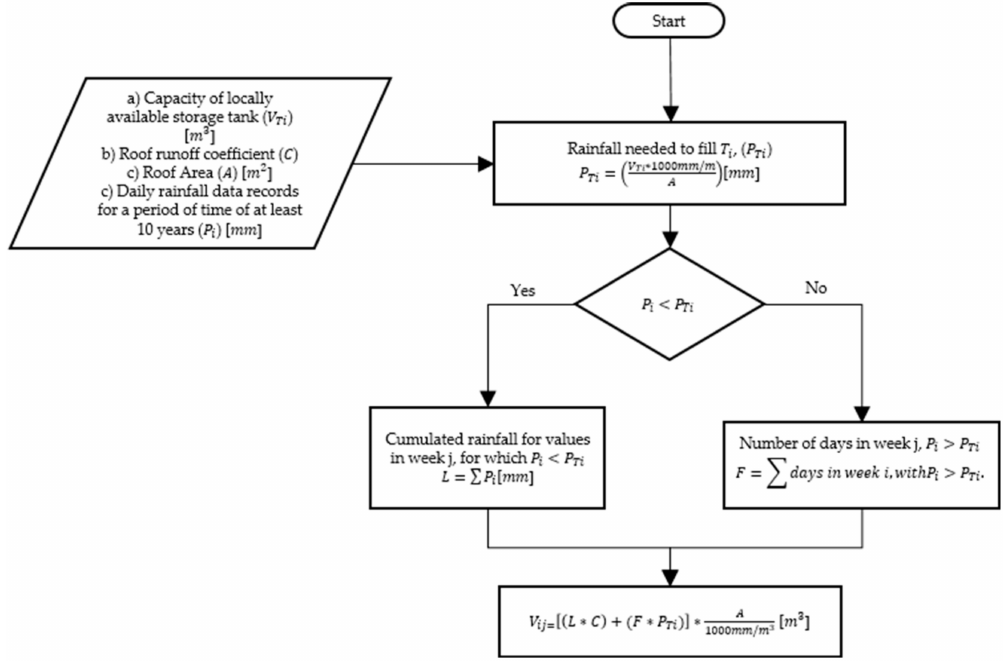
Figure 1. Procedure for dimensioning the rainwater storage